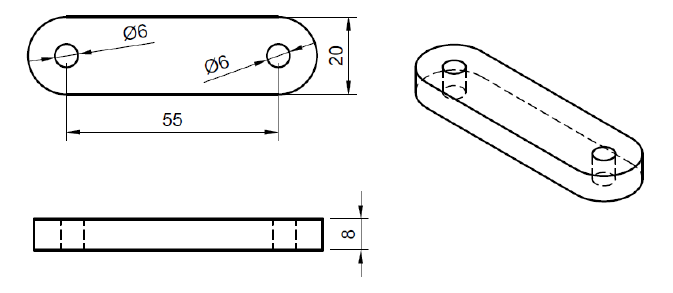
Figure 8. Schematic representation of the connecting rod. Sizes shown are just for reference and have not been optimized. The design will require